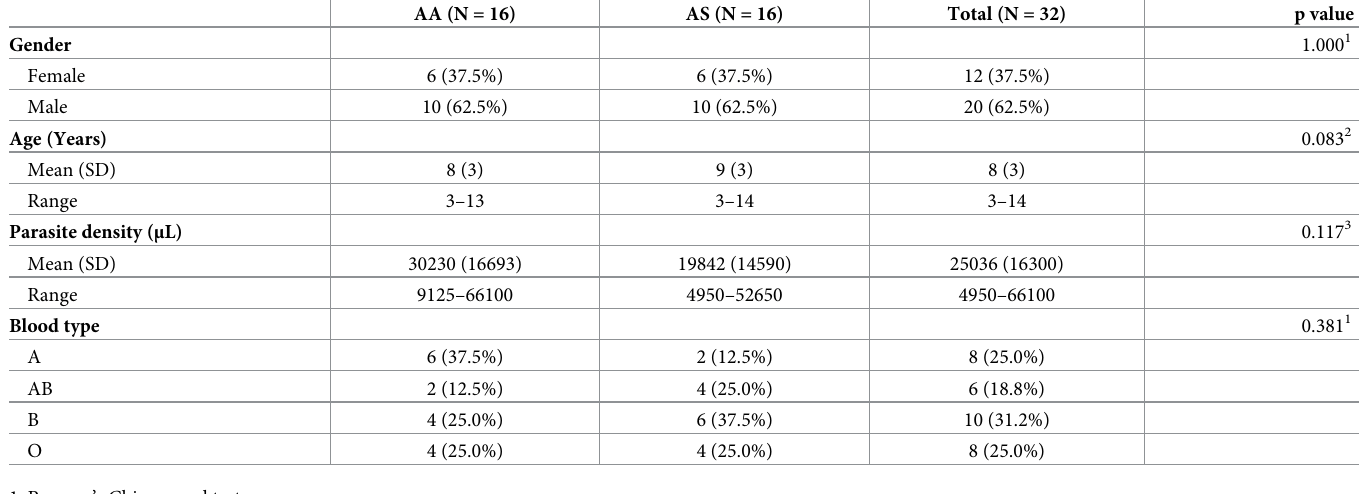
Table 1. Summary of matched HbAA and HbAS study participant characteristics. Blood samples from 32 children with uncomplicated P . falciparum malaria in Mali: 16 samples from children with hemoglobin AS genotype (AS) and 16 matched samples from children with hemoglobin AA genotype (AA). SD, standard